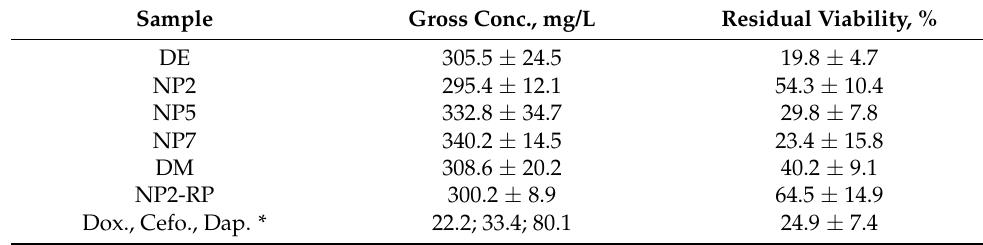
Table 3. Effect of DE and its fractions on the seven-day old stationary phase B. burgdorferi .